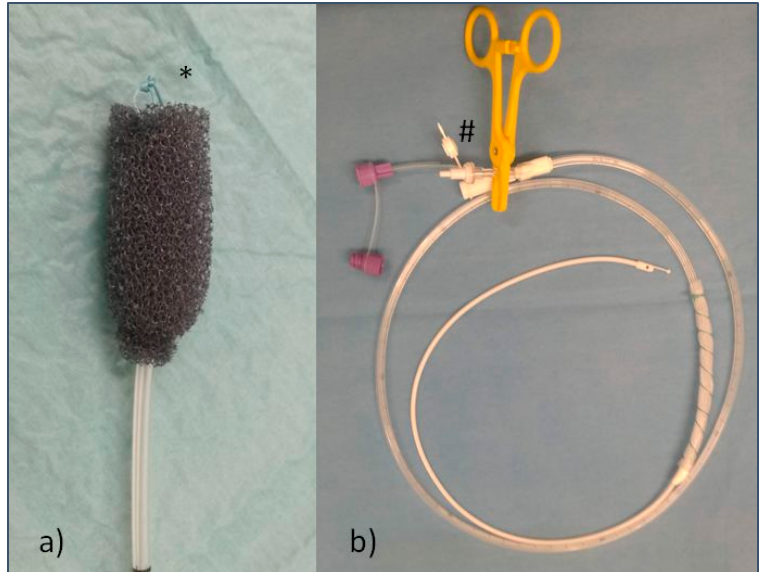
Figure 2. Illustrations of the two ENPT devices used; ( a ) OPD (open-pore polyurethane sponge) with suture loop (*) for forceps maneuver; ( b ) OFD (open-pore film drainage), prepared Freka ® Trelumina tube; the gastric part is wrapped with CNP Drainage Film and fixed with suture, and the venting tube is clamped (#).